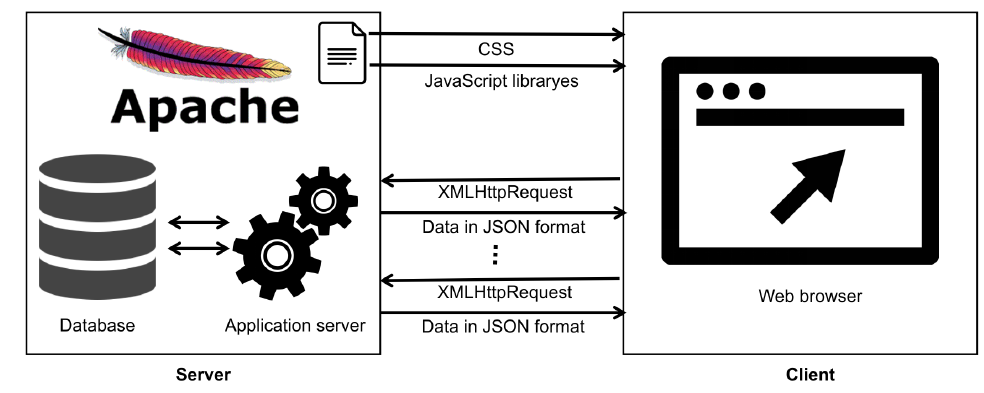
Figure 7. Simplified schema of server—client interactions and web application loading